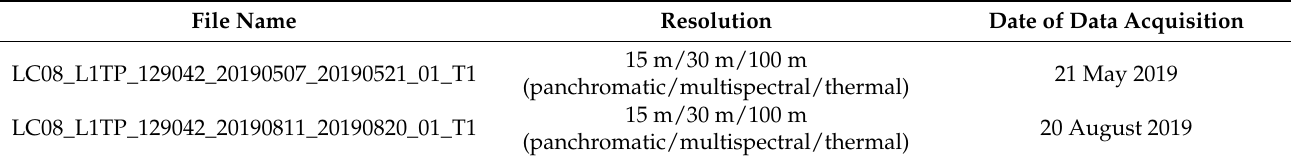
Table 1. Landsat 8 remote sensing images used for the calculation of vegetation coverage